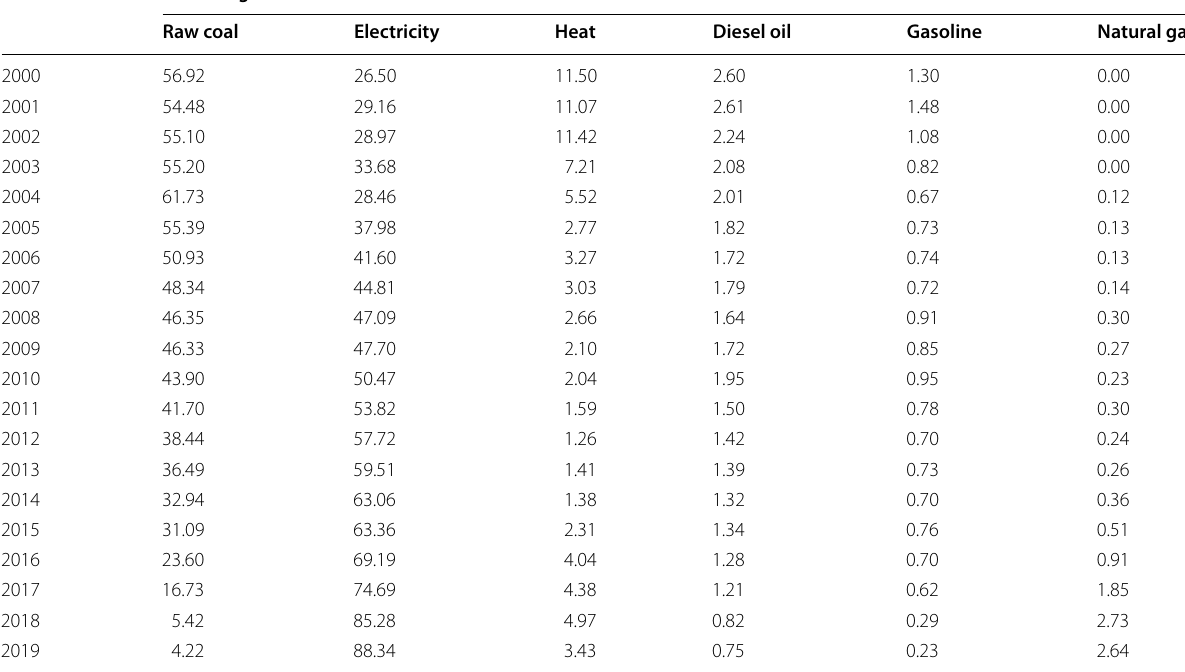
Table 2 Contribution rates of CO Years Percentage/